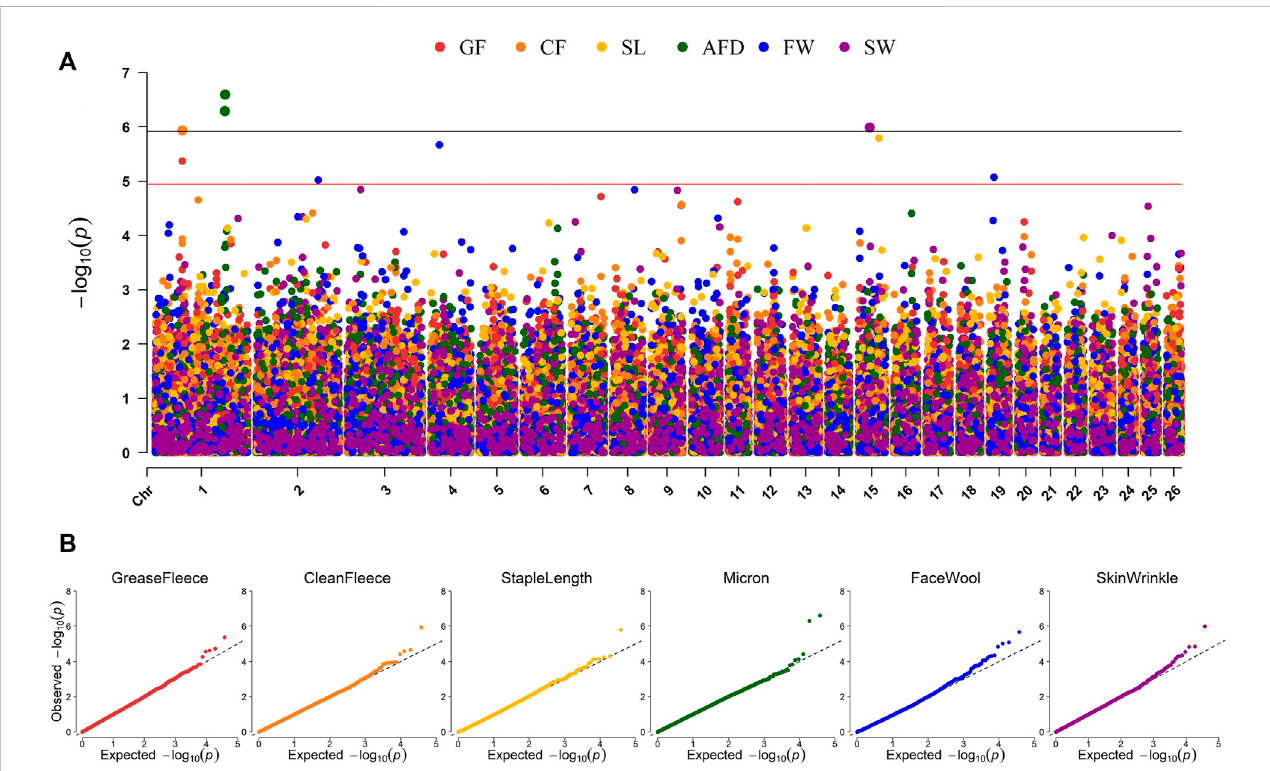
FIGURE 4 ManhattanandQQplotsrepresentingEMMAXGWASresultsforsixcontinuouswoolcharacteristics. (A) ManhattanplotrepresentingtheGWASresultsof six wool traits. p -values are represented by: grease fl eece wt. 365 adj., red; clean fl eece wt. 365 adj., orange; staple length 365 adj., yellow; average fi ber diameter, green; face wool score, blue; skin wrinkle score, violet. Genome-wide signi fi cance is given by p -values < 1.19e-06 (black line) and chromosome- wide signi fi cance is given by p -values < 1.13e-05 (red line). (B) Quantile-Quantile (QQ) plots for each GWAS displaying the expected versus observed – log10 ( p